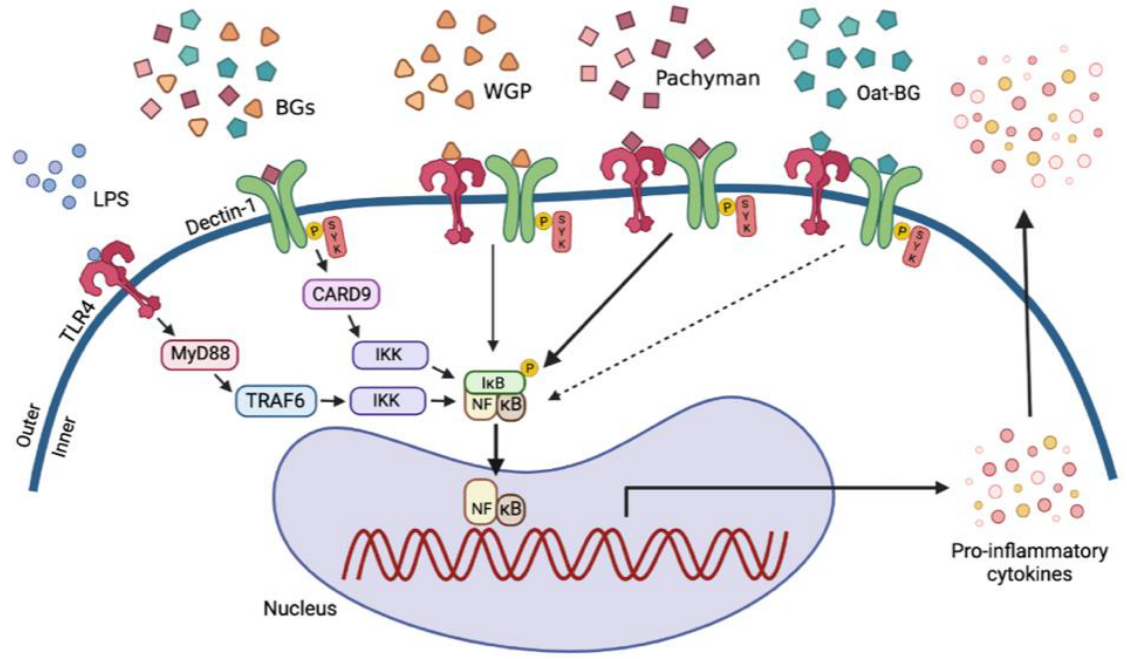
Figure 9. The proposed working hypothesis demonstrates the possible additional proinflammatory impact with lipopolysaccharides (LPS) plus the different forms of (1 → 3)- β -D-glucan (BGs), includ- ing whole-glucan particles (WGP; BGs with 1,6 linkage), Pachyman (BGs without 1 → 6 nor 1 → 4 linkages), and Oat β -glucans (Oat-BG; BGs with 1,4 linkage), through the crosslink between Toll-like receptor-4 (TLR-4) and Dectin-1, the pattern recognition receptors for LPS and BGs, respec- tively, with Spleen tyrosine kinase (Syk), an inhibitor of nuclear factor kappa-B kinase (IKK), and nuclear factor kappa B (NF- κ B) as the downstream signals (thickness of the arrows represents the intensity of the activation). While Myeloid differentiation primary response 88 (MyD88) and Syk-Caspase recruitment domain-containing protein 9 (CARD-9) are the main downstream signals of TLR-4 and Dectin-1, respectively [48,64,82], the crosslink of Dectin-1 with TLR-4, by a proper form of glucan (Pachyman), induced stronger signaling through Syk and NF- κ B [64]. TRAP-6, Thrombin Receptor Activator for Peptide 6; I κ B, I kappa B kinase. The picture is created by BioRender.com (accessed on 1 March